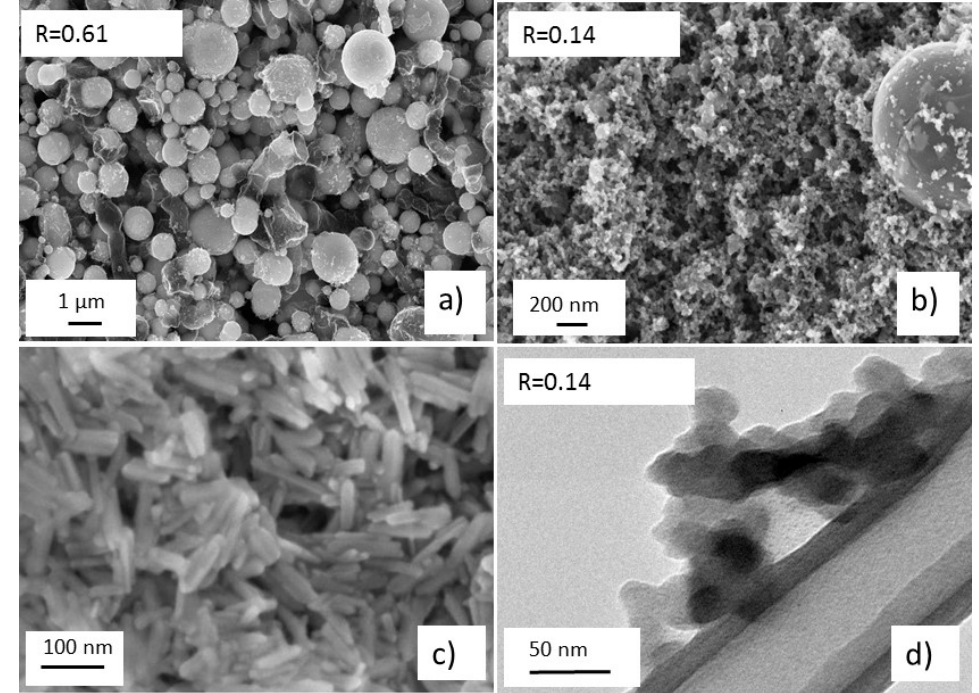
Figure 3. Scanning electron microscopy images of nanomaterials obtained from LPM-1: ( a ) R = 0.61; ( b ) R = 0.14; ( c ) is the pristine FeOOH nanoparticles used in LPM-1; ( d ) is a TEM image recorded for R = 0.14.